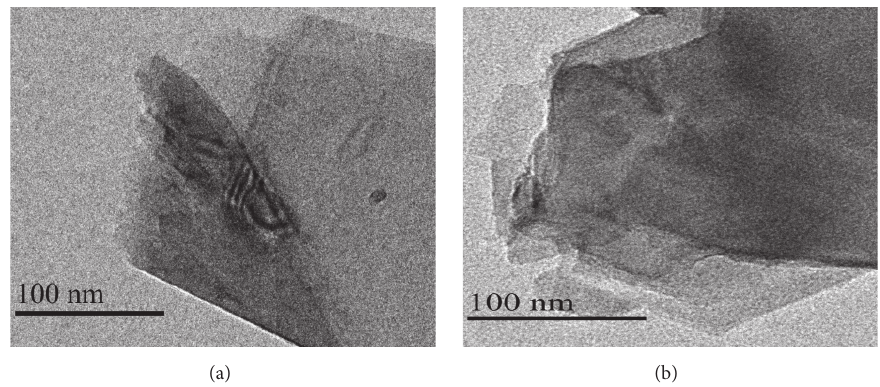
Figure 11: TEM diagrams of fresh MoS 2 catalysts (a) and spent MoS 2 catalyst